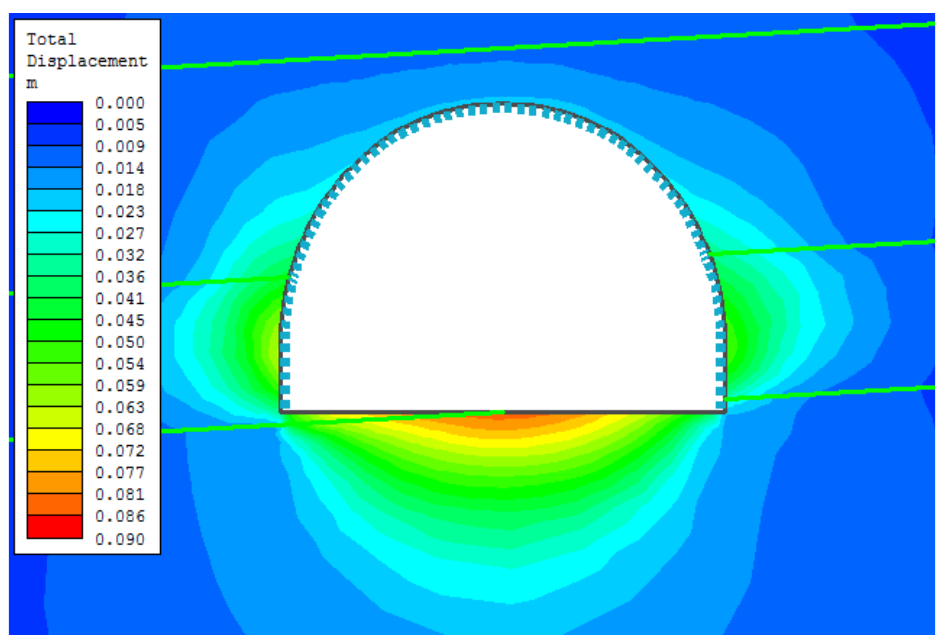
Figure 14. Initial convergence results for roadway F-33.